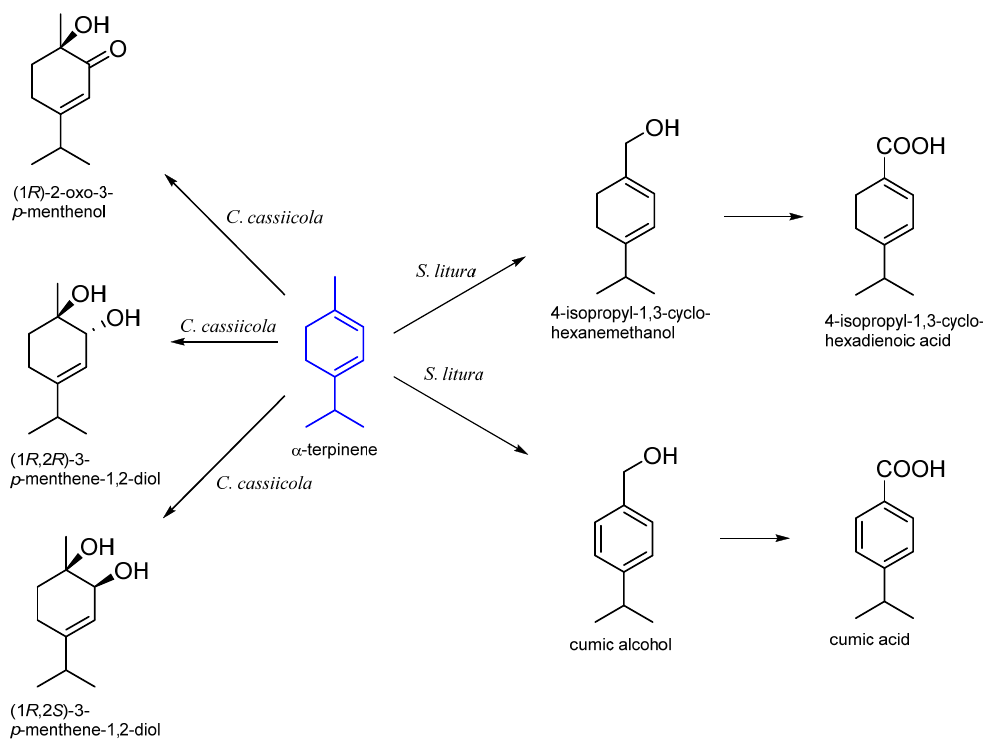
Scheme 5. Biotransformation of racemic α -terpinene. Table 2. Biotransformation of α -terpinene.